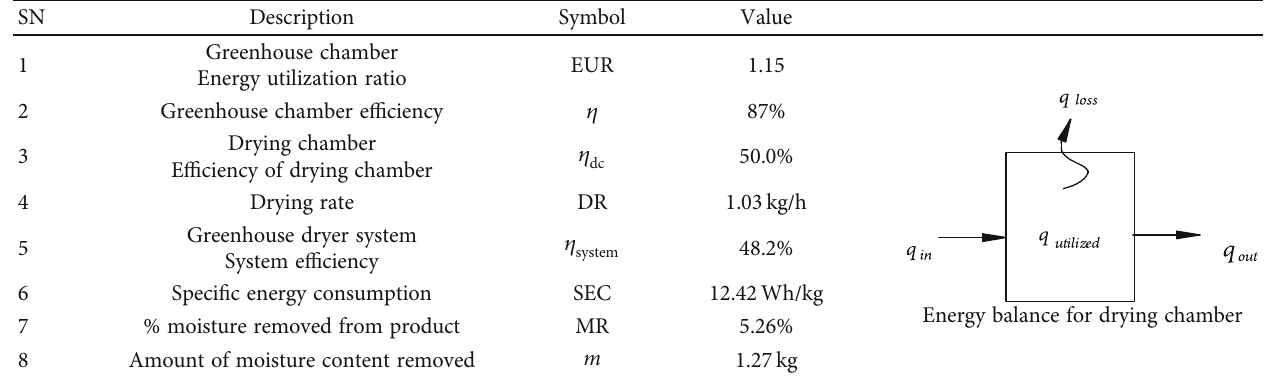
Figure 3: Variation of relative humidity and solar radiation (W/m 2 ) against time of the day in natural and forced convection (using RSM).. Table 3: Important results of greenhouse dryer analysis.